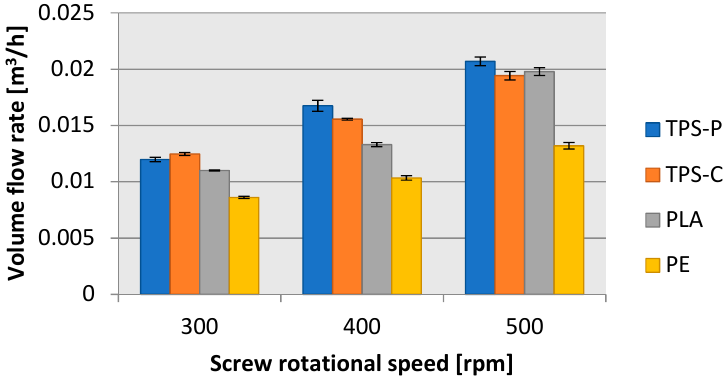
Figure 16. Relationship between the volume flow rate of the material and the rotational speed of the extruder screw.